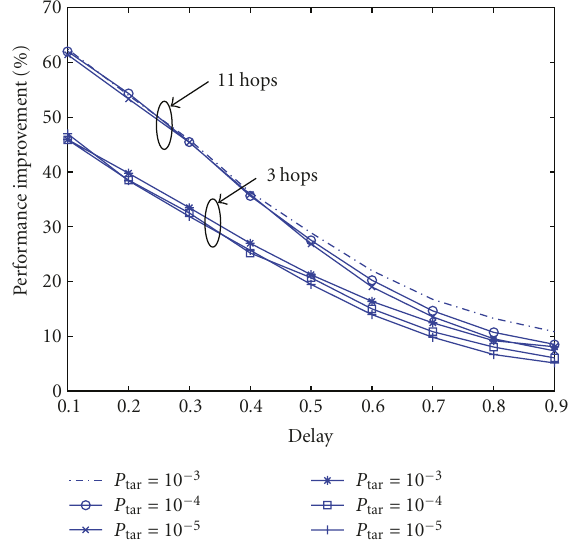
Figure 4: Performance improvement for di ff erent delay constraints under di ff erent P tar